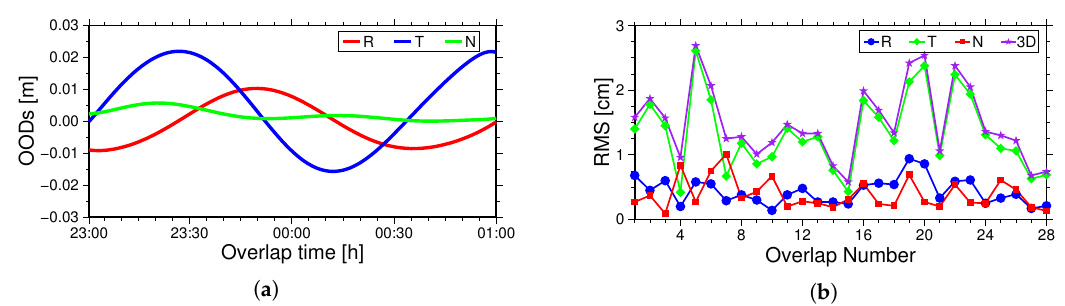
Figure 7. ( a ) is the OODs of the first overlapping arc in the R, T N and 3D directions. ( b ) is the RMS statistics of the total 28 overlapping arcs in the R, T, N and 3D